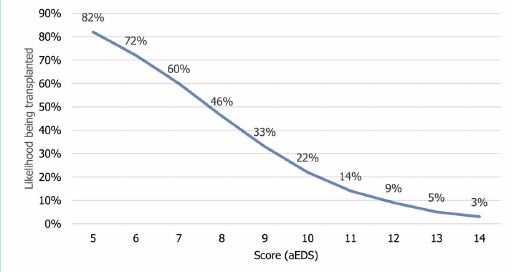
Figure 4: Probability of a donor lung being transplanted in Switzer- land according to adapted Eurotransplant donor score (aEDS), based on a logistic regression model.